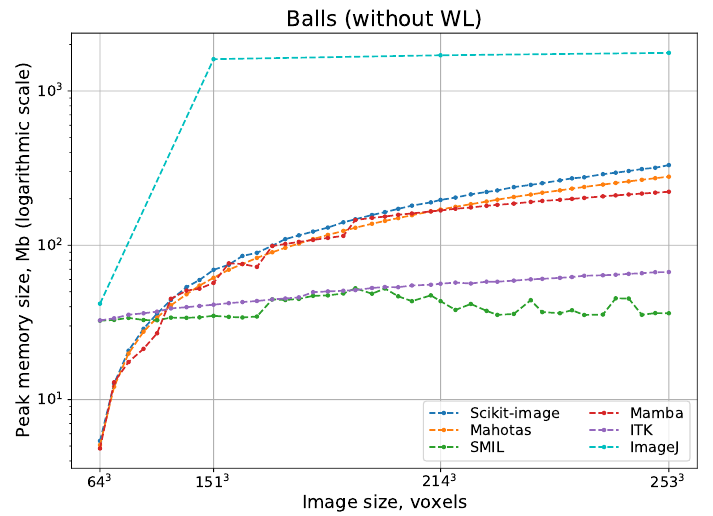
Figure 14. Peak memory consumption for watershed without WL depending on 3D image